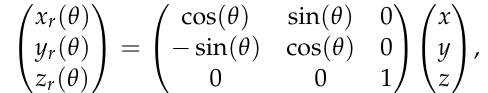
where ( , , ) x y z is the coordinate of a point in the imaged object, and ( ( ), ( ), ( )) is the rotation coordinate of ( , , ) x y z at the rotation angle θ .